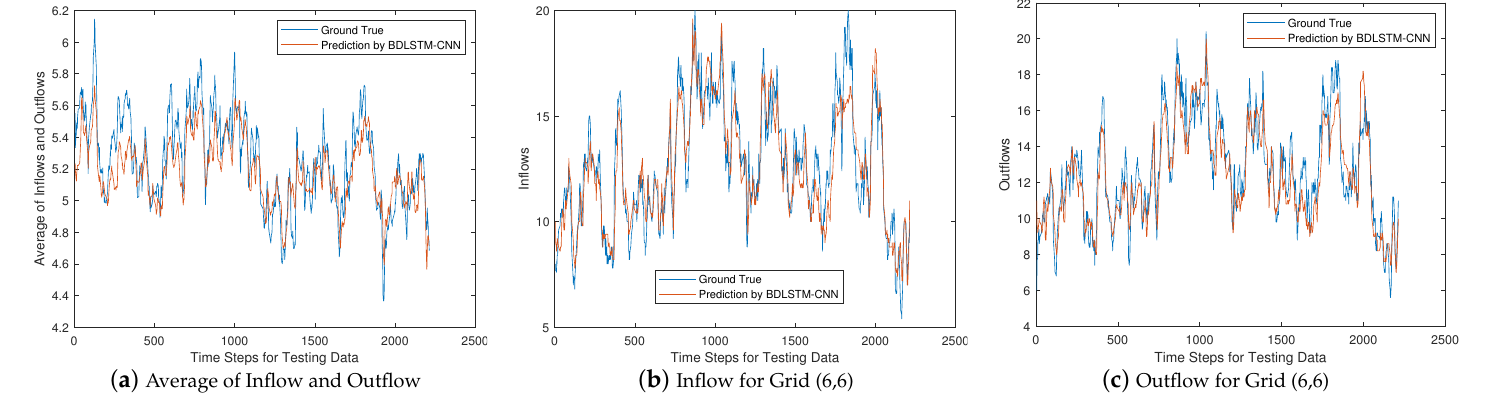
Figure 8. Prediction for Y t = X t + 1 .